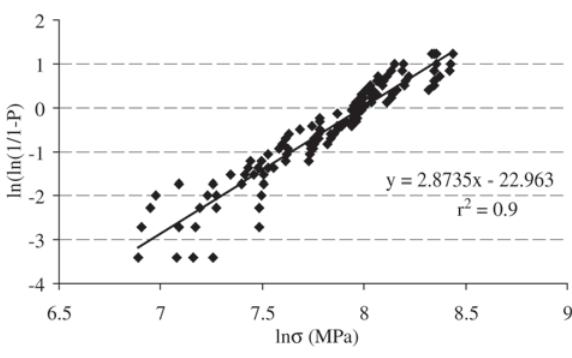
Figure 14. Weibull plots for tensile strength of carbon fibres for all test specimen